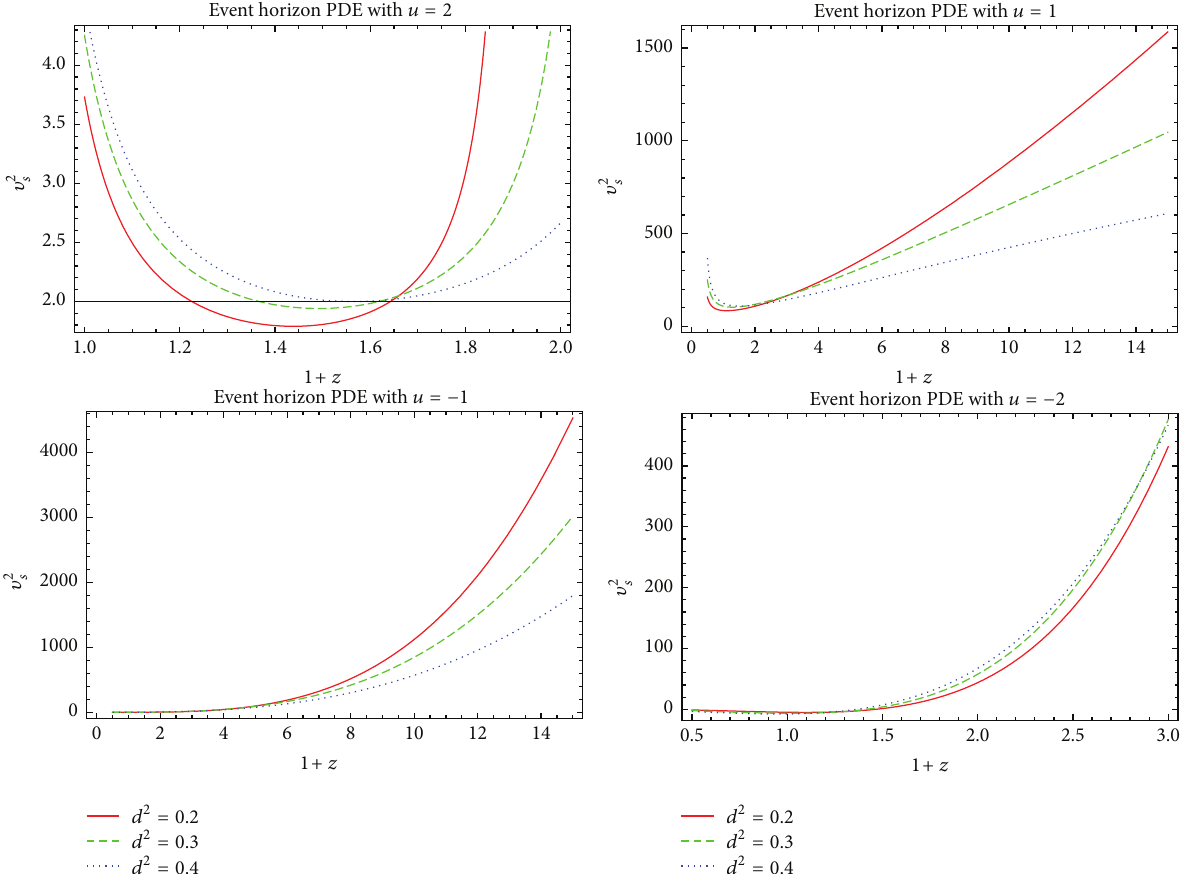
Figure 8: Plot of 𝜐 2 𝑠 versus 1 + 𝑧 for event horizon PDE in dynamical Chern-Simons modified gravity with 𝑢 = 2, 1, −1,−2 .